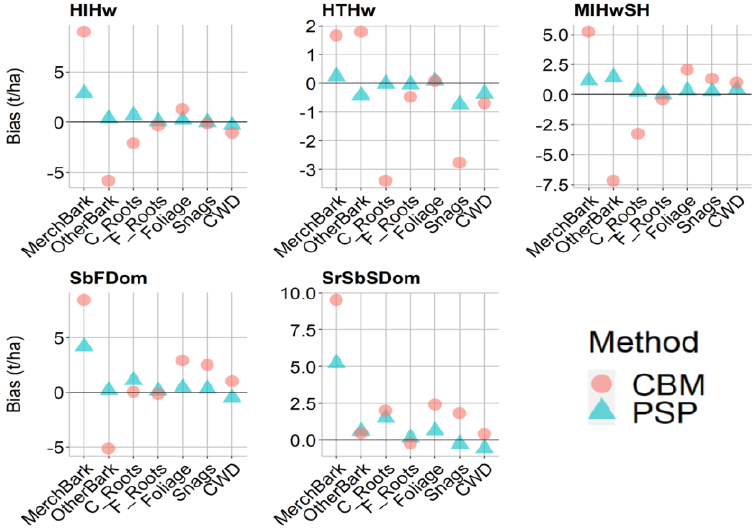
Figure 8. Bias of PSP- and CBM-derived estimations of pool-level carbon when compared to an independent, observed PSP dataset ( n = 100 per community) by forest community and carbon pool.